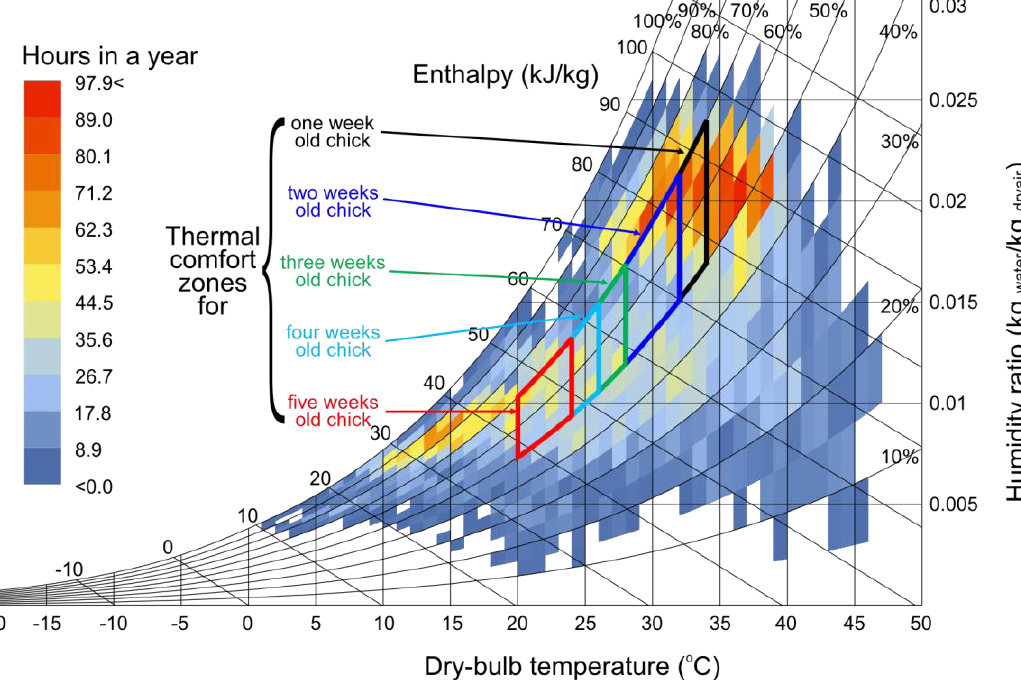
Figure 2. Psychrometric distribution of climatic conditions (hourly basis) of Multan associated with thermal comfort zones of poultry birds.